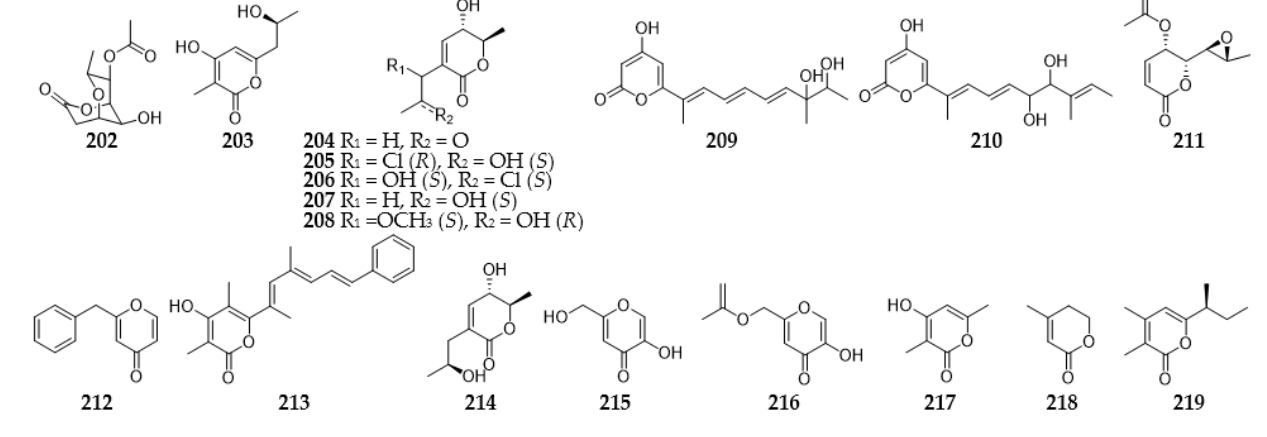
Figure 13. Aspergillus -derived pyranones ( 202 – 219